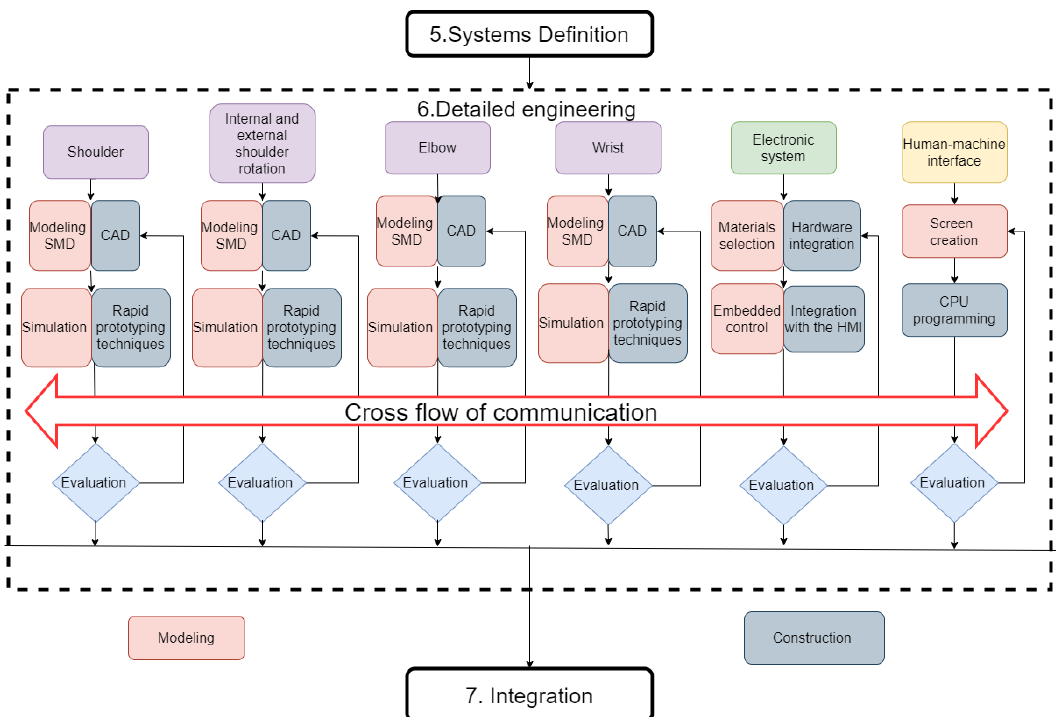
Figure 4. Detailed engineering for the